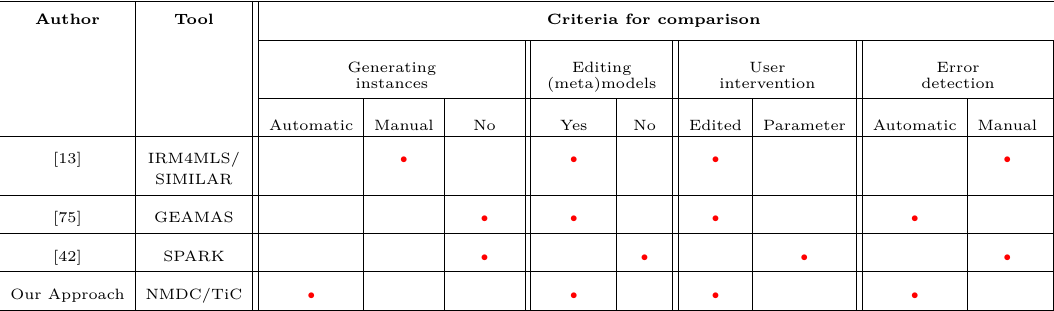
Table 1. Comparison between the main approaches of